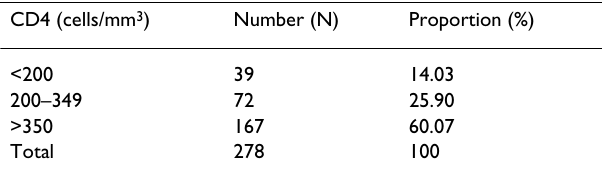
Table 4: T-lymphocyte (CD4) count among antenatal attendees CD4 (cells/mm 3